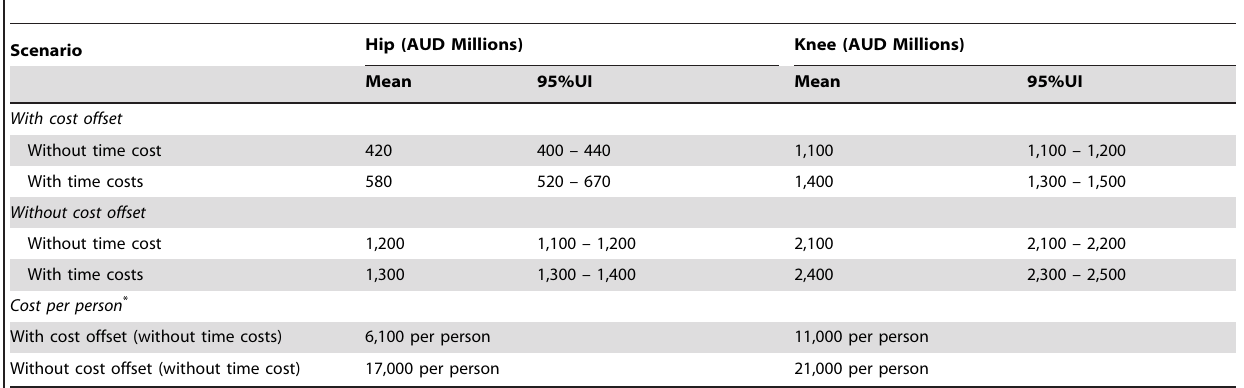
Table 7. Costs under different